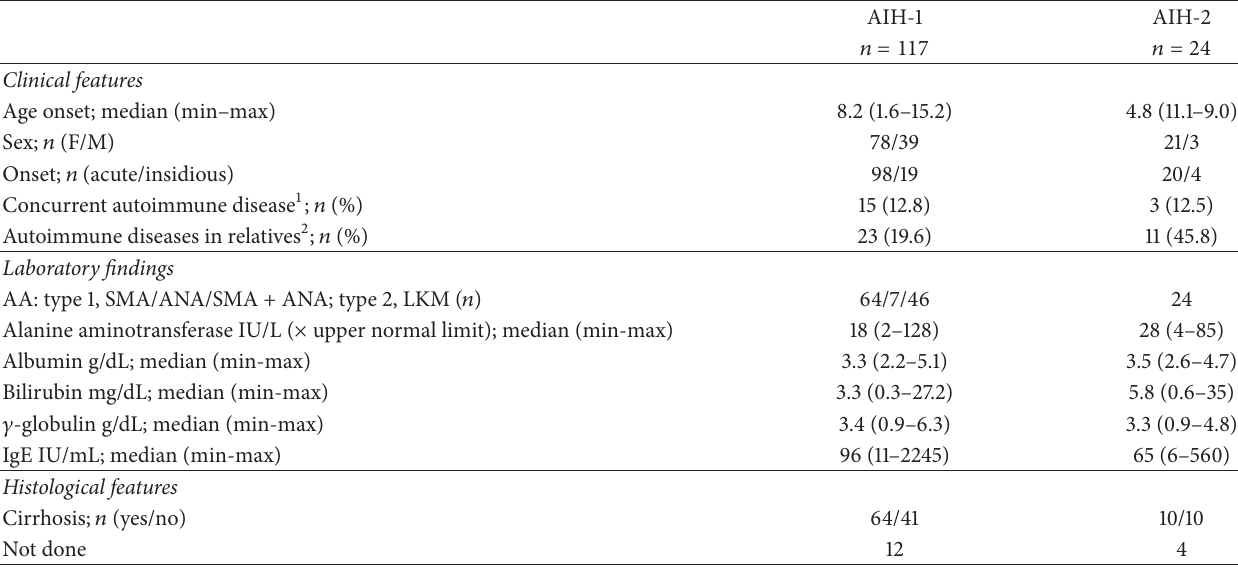
Table 1: Clinical and laboratory findings of children with type 1 and type 2 autoimmune